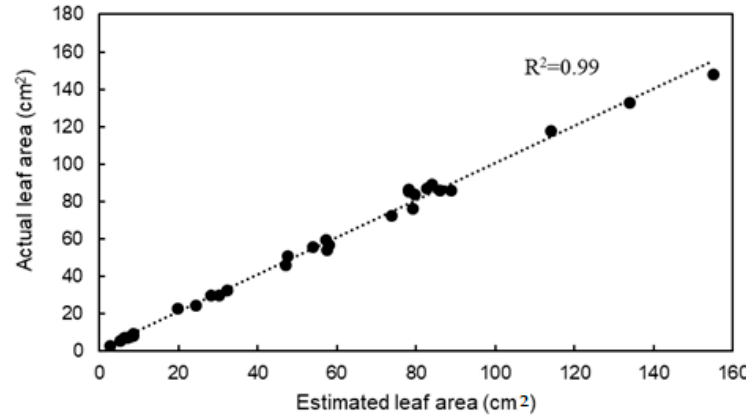
Figure 6. Relationship between estimated leaf area based on number of voxels and actual leaf area.